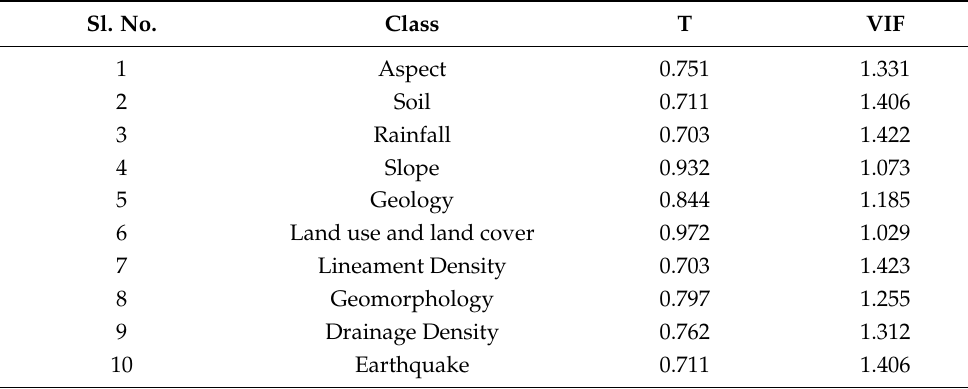
Table 4. Multi-collinearity analysis of landslide conditioning factors.